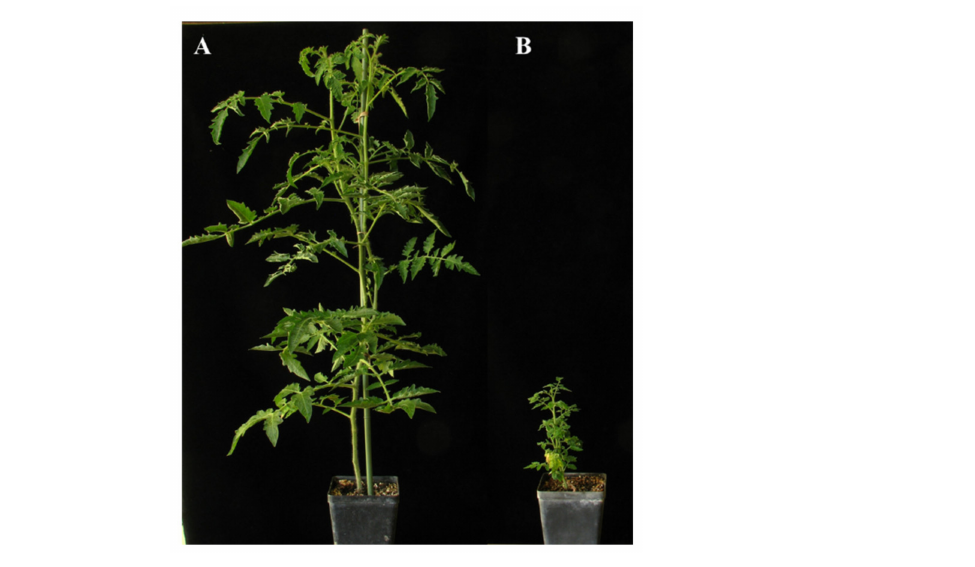
Figure 17. Extreme stunting and growth arrest in tomato plants artificially infected by Potato spindle tuber viroid. ( A ) Healthy plant. ( B ) Infected